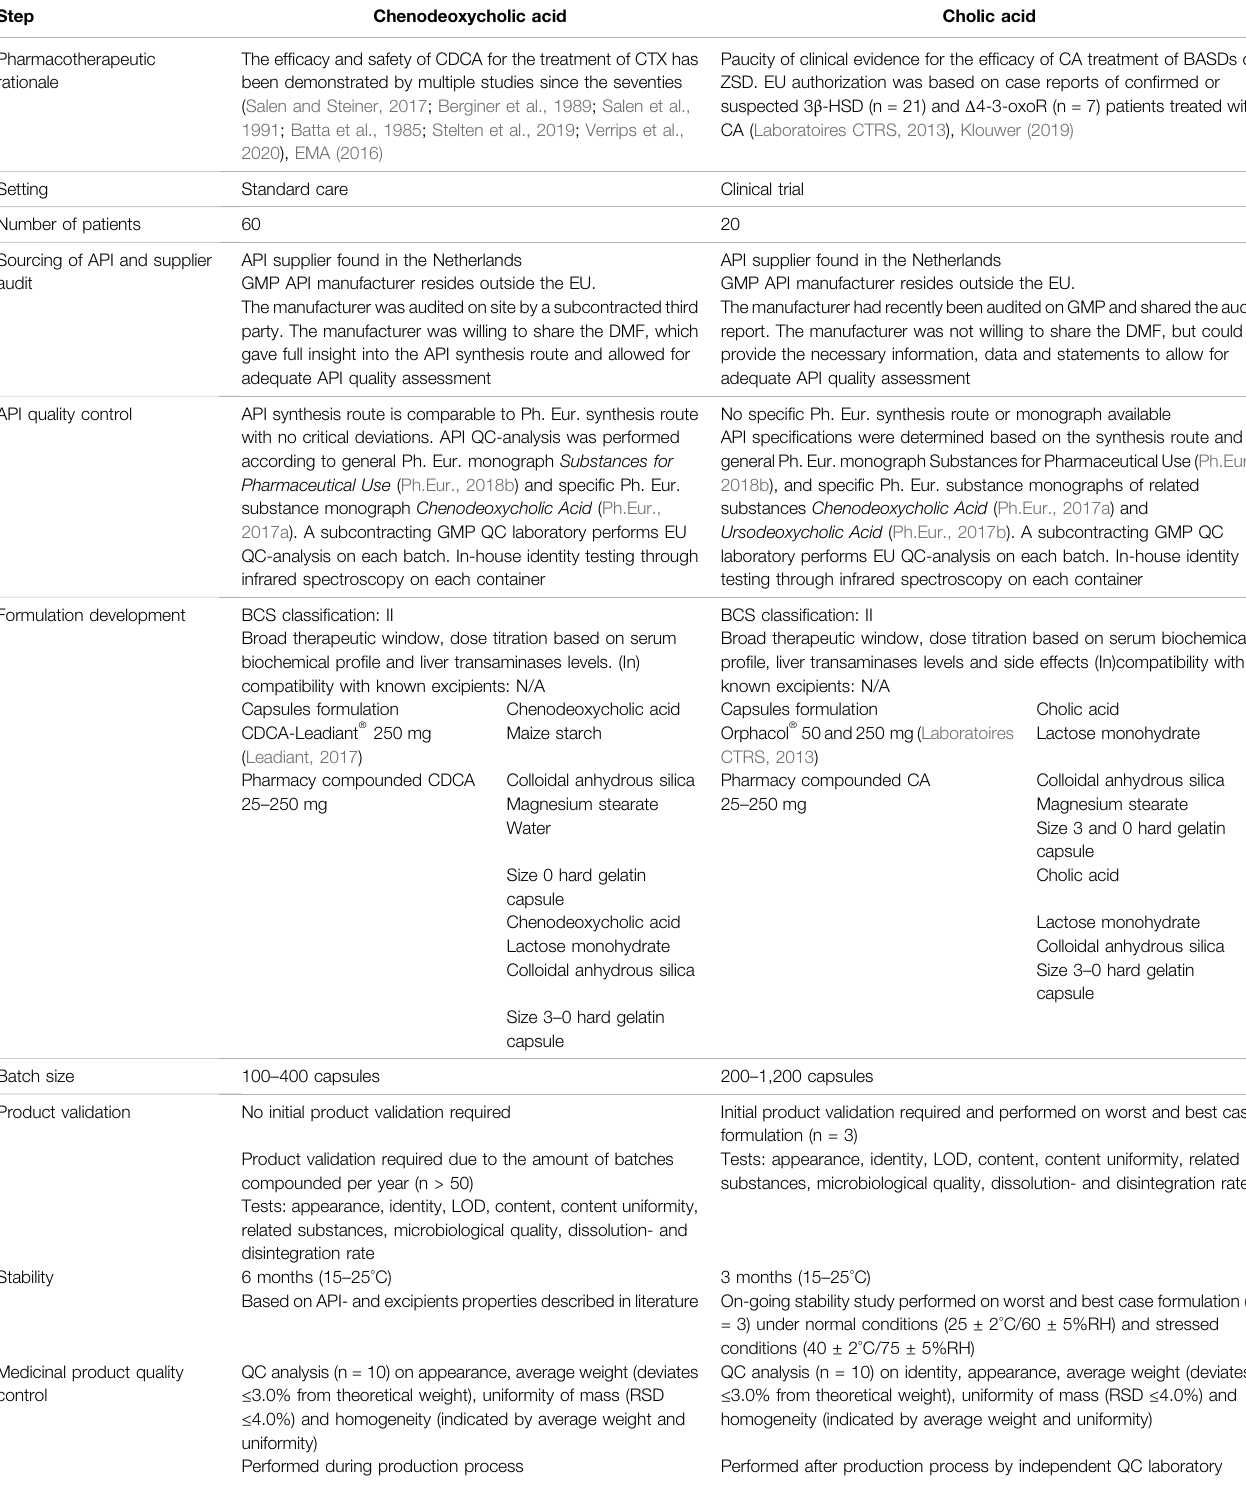
TABLE 1 | Explanation and implementation of critical steps in the development process of pharmacy compounded CDCA and CA capsules. Chenodeoxycholic